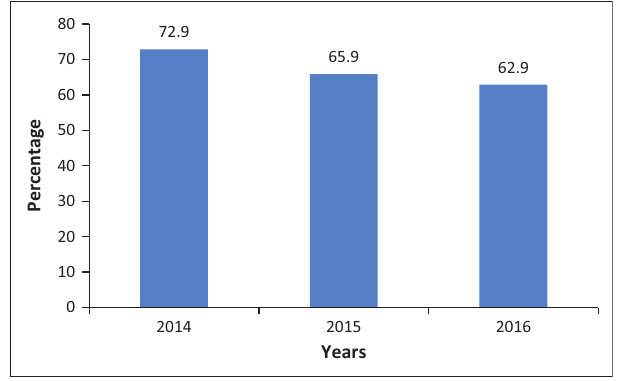
FIGURE 3: Matric results in Limpopo, 3-year